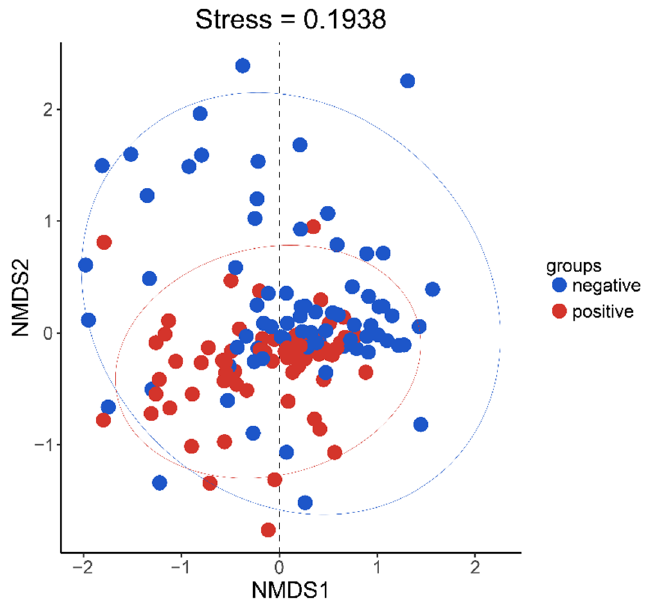
Figure 4. NMDS analysis of the two treatment groups. Positive is the treatment where dry matter mass is positively related to volume; negative is the treatment where dry matter is negatively related to